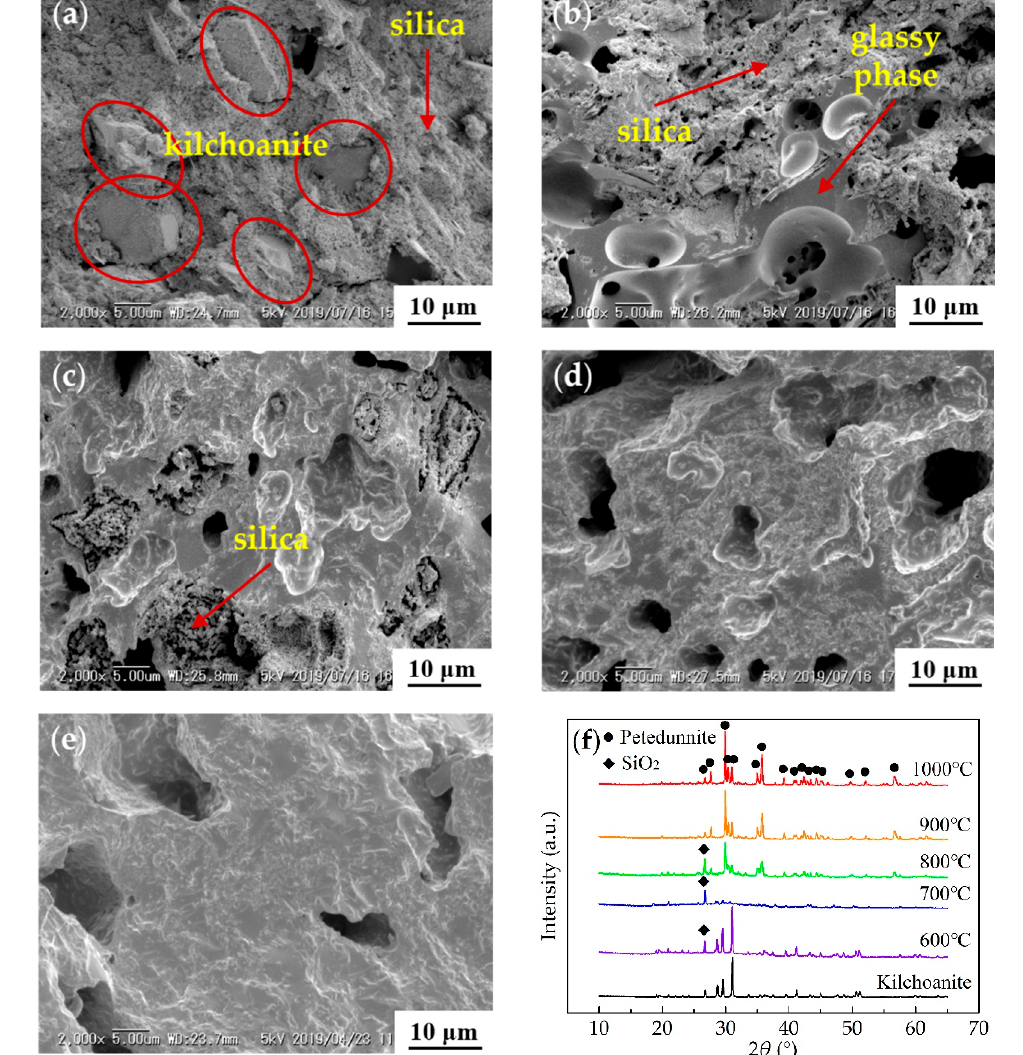
Figure 3. SEM images of samples sintered at different temperatures: ( a ) 600 °C; ( b ) 700 °C; ( c ) 800 °C; ( d ) 900 ◦ C; ( e ) 1000 ◦ C; and ( f ) XRD patterns of di ff erent ( d ) 900 °C; ( e ) 1000 °C; and ( f ) XRD patterns of different samples.